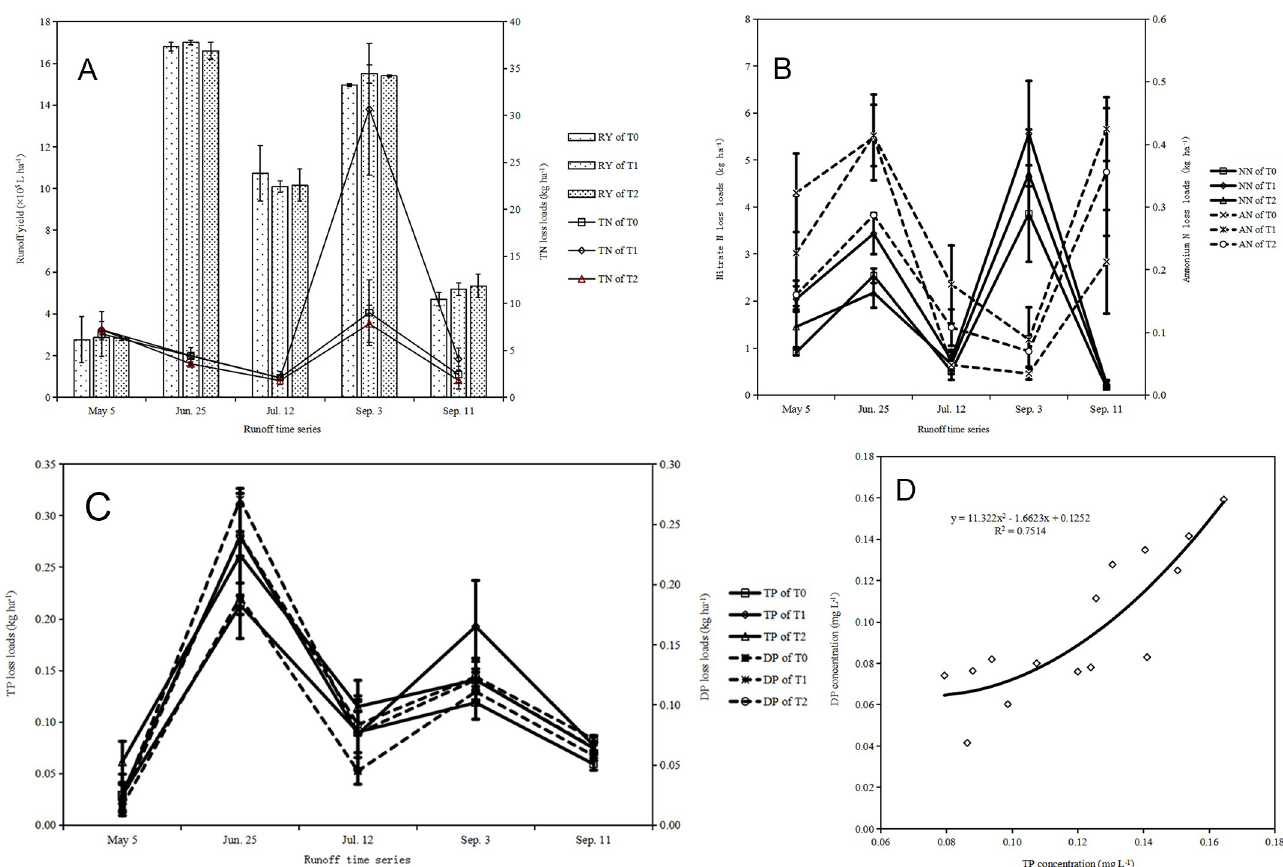
Fig 3. Runoff Nitrogen (N) and phosphorus (P) losses from rice fields as influenced by the treatments T0, T1, and T2 from January to December 2018: Accumulated TN losses (A), AN and NN concentrations (B), accumulated TP and DP losses (C), and relationship between TP and DP concentrations (D). Notes: T0 = Traditional irrigation; T1 = Traditional irrigation and fertilization practice; T2 = Water-saving irrigation and optimizing fertilization. RY: Runoff yields. TN: Total N; NN: Nitrate N; AN: Ammonium N; TP: Total P; DP: Dissolved